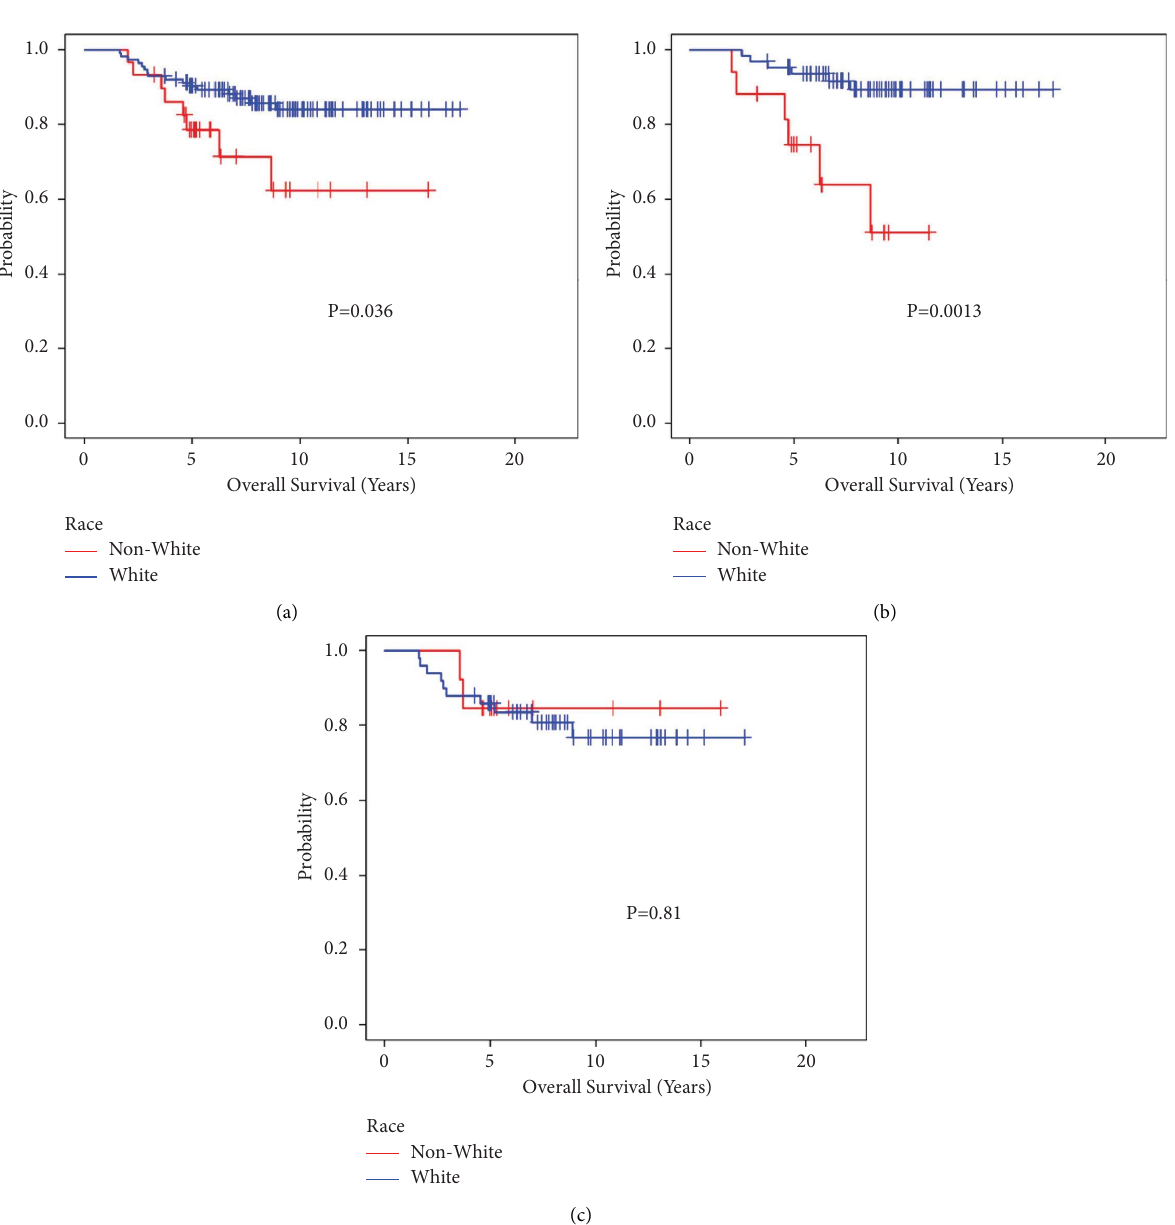
Figure 1: Overall survival by race/ethnicity among (a) all patients ( n � 144), (b) patients with contralateral prophylactic mastectomy ( N � 81), and (c) patients without contralateral prophylactic mastectomy ( n �